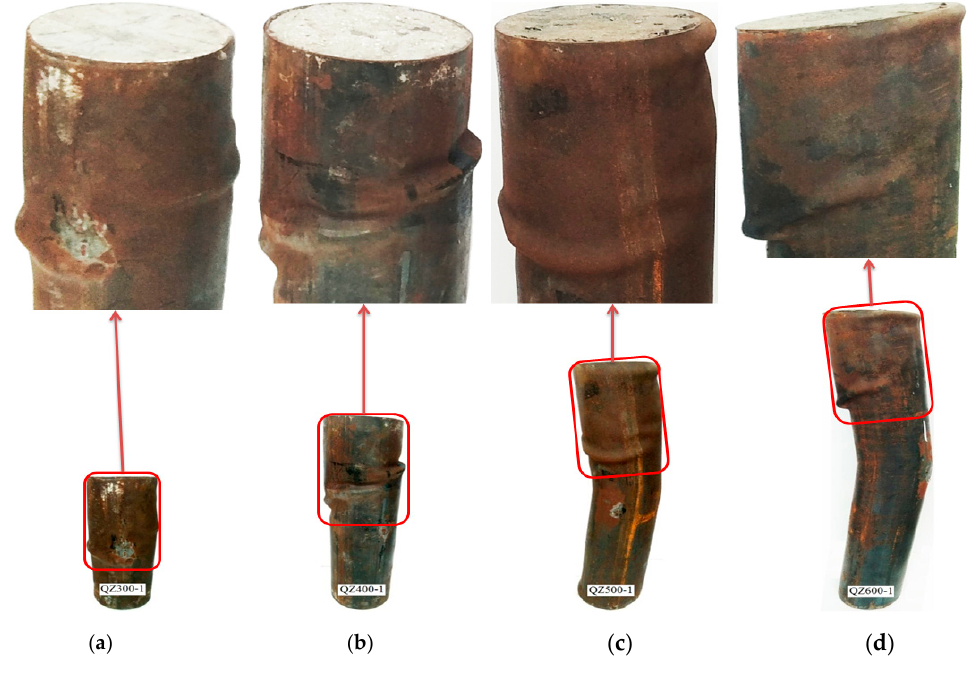
Figure 4. Failure mode: ( a ) λ = 2.6; ( b ) λ = 3.5; ( c ) λ = 4.4; ( d ) λ = 5.3.